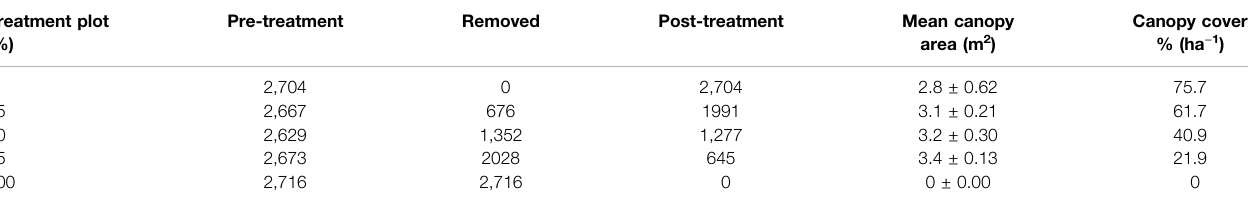
TABLE 1 | The pre and post-treatment densities (ha − 1 ), mean canopy area and cover of woody plants in the various thinning plots in the savanna of southern Ethiopia. Treatment plot (%)